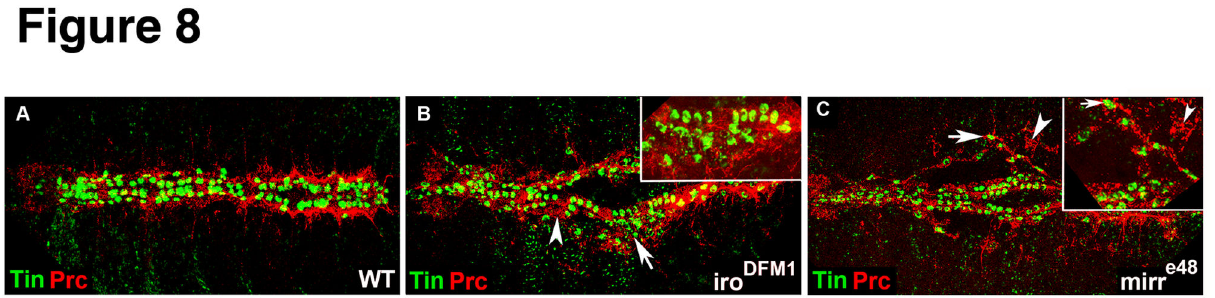
Figure 8. Double immunostainings for Tin and the pericardial marker Pericardin (Prc) confirm heart phenotypes affecting pericardial cells in iro DFM1 and mirr e48 embryos. (A) Wild-type expression of Tin and Prc at stage 16. (B) Prc expression is expanded in iro DFM1 embryos (arrowhead) and includes additional Tin-positive cells (arrow). The inset is a higher magnification of the area around the arrow. (C) A mirr e48 embryo showing the detachment phenotype of Tin-expressing pericardial cells (arrows) and ectopic Prc expression (arrowheads). doi: